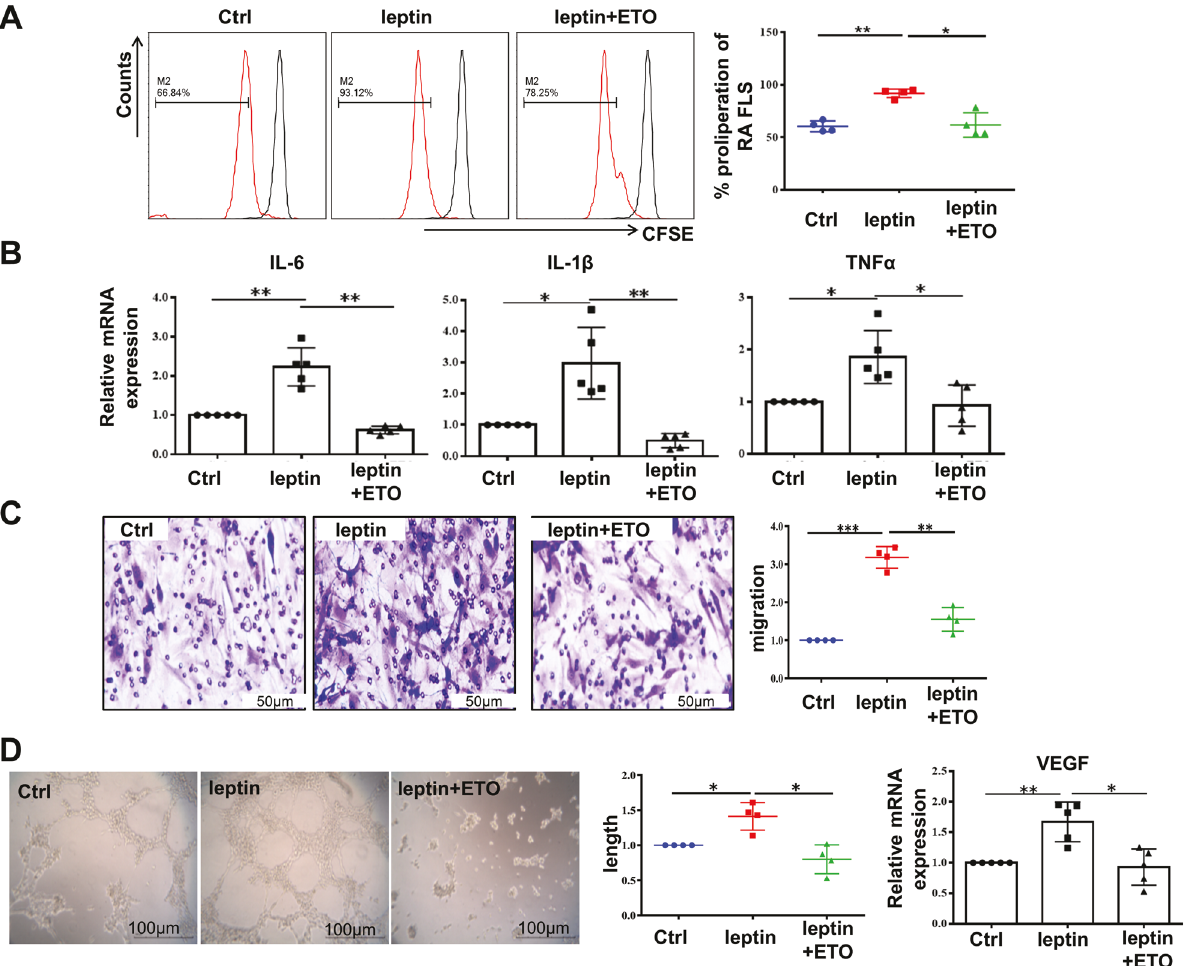
Fig. 5 Leptin-upregulated FAO was responsible for in fl ammatory phenotypes of RA-FLS. RA-FLS were handled by vehicle, leptin (100 ng/mL) with or without ETO (100 μ M) for 24 h. RA-FLS were labeled with CFSE and analyzed by fl ow cytometry for proliferation ( A , n = 4). B Expression of IL-6, IL-1 β and TNF- α in RA-FLS was tested with real-time PCR analysis ( n = 5). C Transwell migration assay was carried out to evaluate migration potential of RA-FLS (scale bar = 50 μ m, n = 4). D Supernatant derived from RA-FLS with indicated treatment was added into the culture system of HUVEC. Representative images of capillary-like structures and quantitative analysis of the total tube length were examined at 6 h (scale bar = 100 μ m, n = 4). Expression of VEGF was evaluated by real-time PCR at 24 h. Data are means ± SEM of three independent experiments, statistical signi fi cance was determined as *** P < 0.001, ** P < 0.01, * P < 0.05 compared with